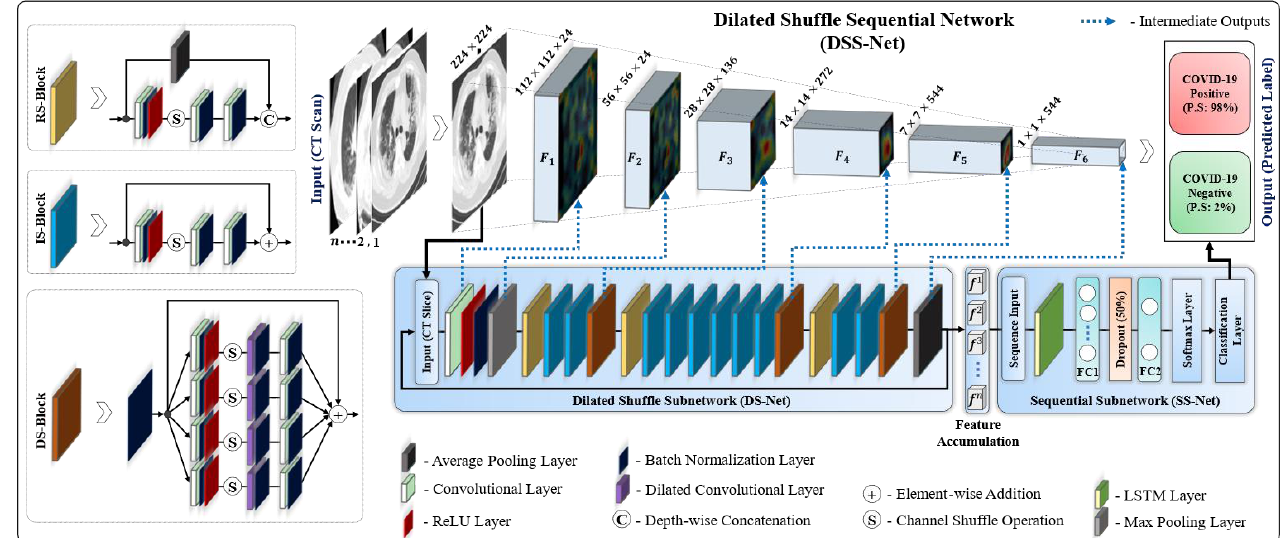
Figure 2. Overall architecture of the proposed dilated shuffle sequential network (DSS-Net) com- prising two subnetworks: dilated shuffle subnetwork (DS-Net) and sequential subnetwork